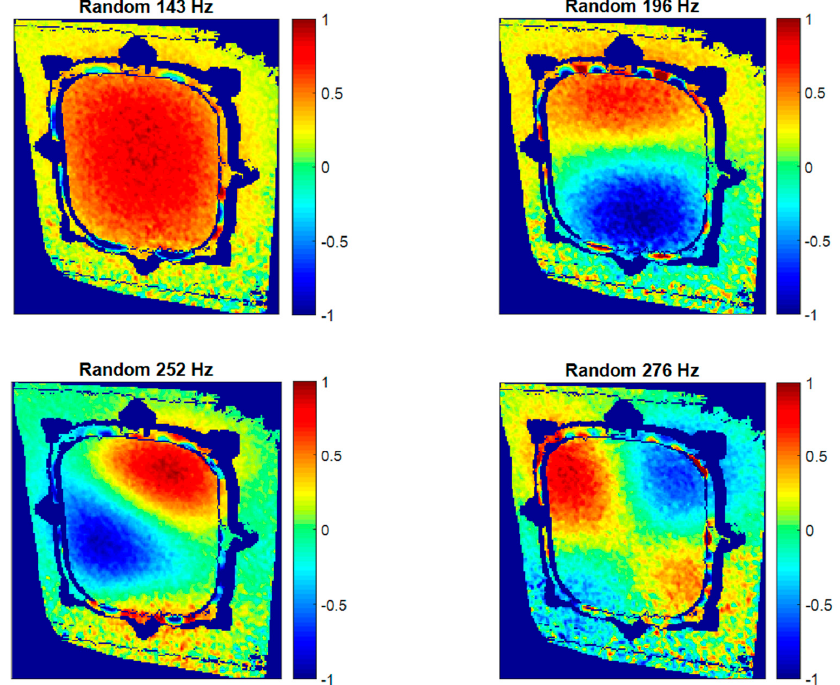
Figure 16. Normalized ODSs in the out-of-plane direction obtained using HS 3D-DIC in a random excitation test under differential pressure.